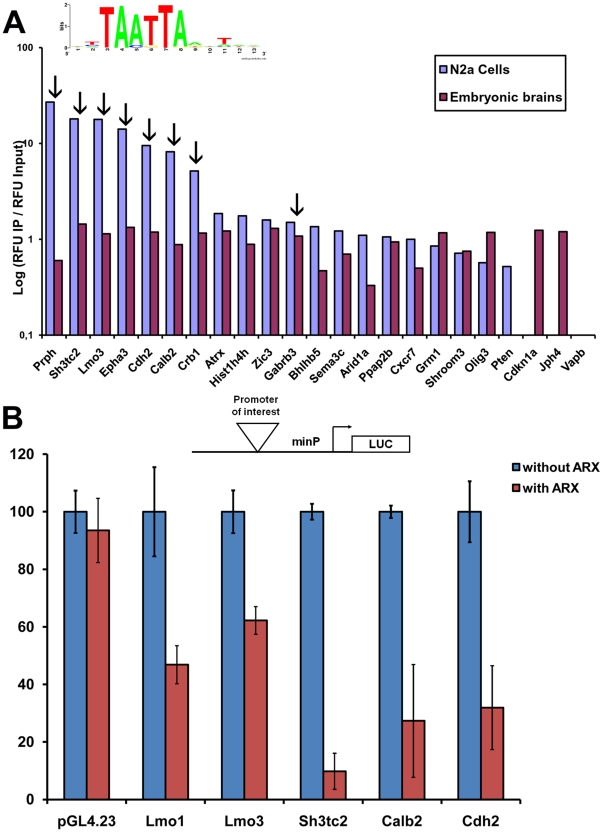
Confirmation of Arx binding to candidate promoter regions.A) Arx-immunoprecipitated DNA was compared to input DNA by ChIP/QFM-PCR to determine ChIP enrichment of 21 putative target genes. No enrichment occurred for the Vapb promoter which was consistently negative in all ChIP experiments. Bar heights represent log10 enrichment of the signal obtained for Arx-immunoprecipitated DNA versus input DNA for each promoter using site-specific primers. The arrows above the bars indicate sequences in which the previously defined Arx-binding motif was found. B) Confirmation of Arx binding to 5 different promoter sequences identified by ChIP using a luciferase reporter gene assay. Firefly luciferase data were normalized to Renilla luciferase expression and data are presented as the percentage of transcriptional activity compared to the vector control. Arx regulation was confirmed for Lmo1, Lmo3, Sh3tc2, Calb2 and Cdh2 promoter regions as transcriptional activity was repressed in the presence of Arx by comparison to the control transfection, whereas it had no effect on the plasmid alone pGL4.23. Error bars indicate SEM.